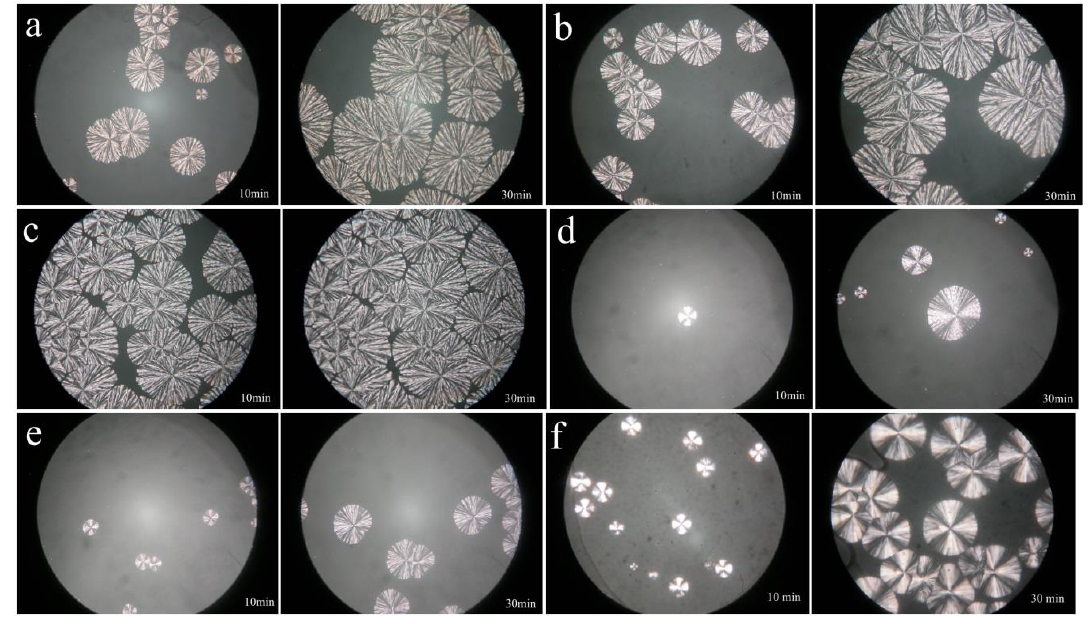
Figure 6. Polarizing microscope images of PLLA and sc-PLAG samples (X200); the glucose content in the feeding of samples: ( a ) 5%; ( b ) 4%; ( c ) 2%; ( d ) 1%; ( e ) 0.5%; ( f ) PLLA.